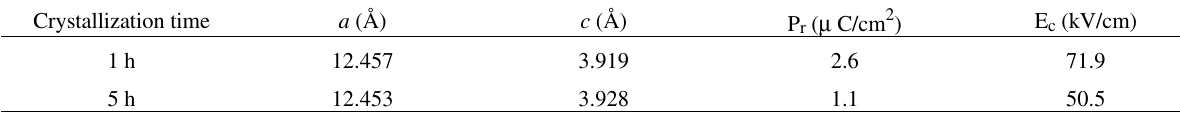
Table 1. Structural and ferroelectric characteristics for SBN films crystallized at 700 °C for 1 h and 5 h. Crystallization